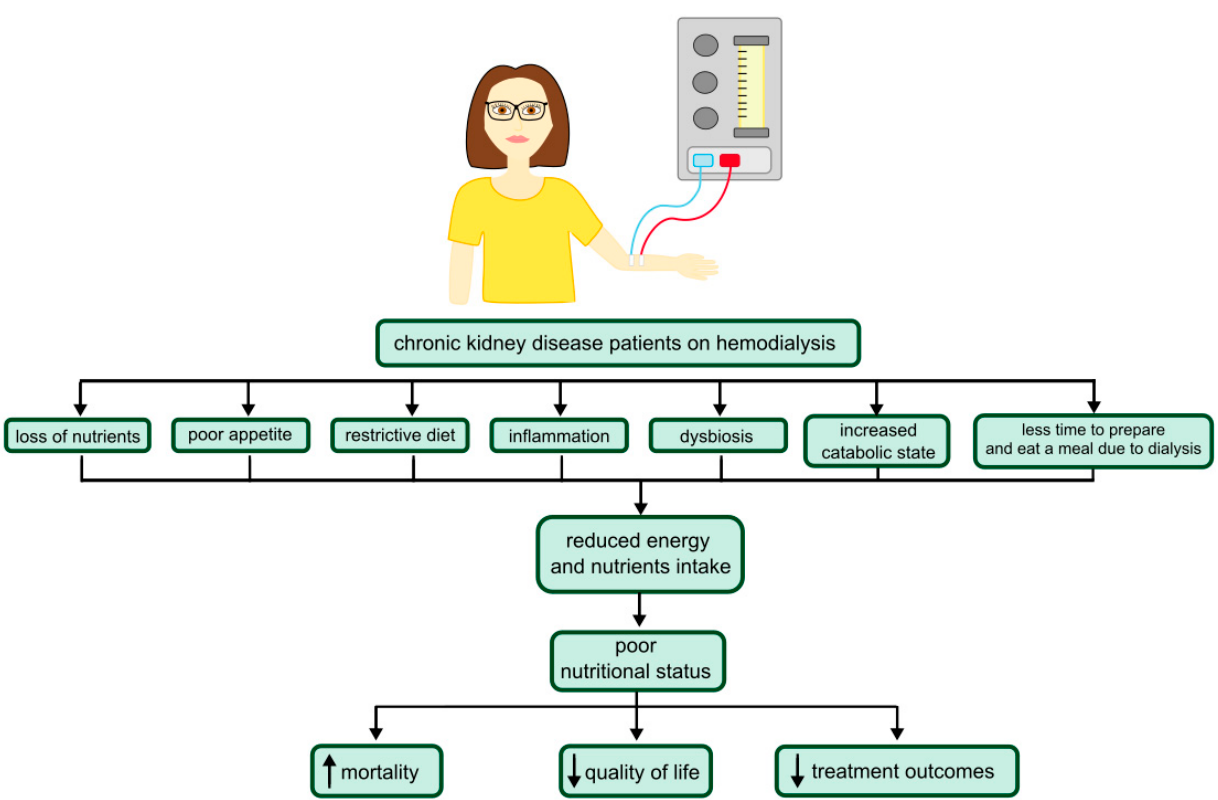
Figure 2. Factors leading to a reduction in energy and nutrient intake and its consequences in hemodialysis patients.